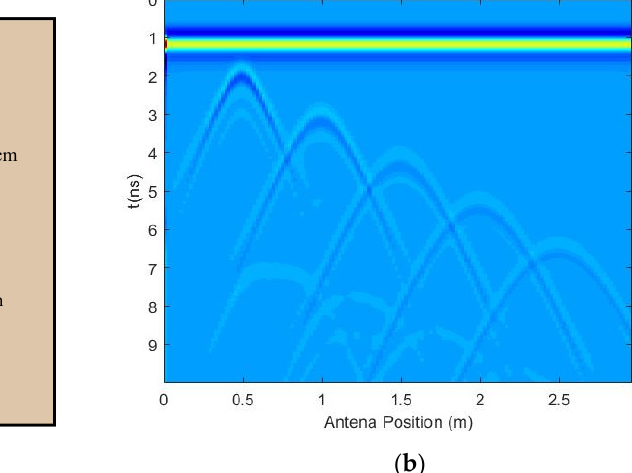
Figure 12. Simulation results at different depths: ( a ) simulation model; ( b ) simulation image.